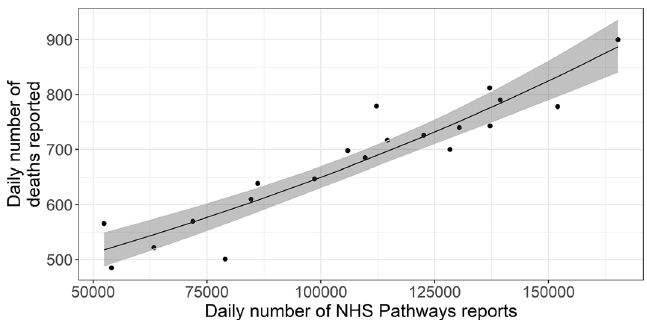
Figure 4. Daily total COVID-19 deaths reported in England between 3rd and 22nd April 2020, against the number of potential COVID-19 cases reported through NHS Pathways with a lag of 16 days (between 18th March and 6th April 2020). The black line and grey ribbon correspond to predictions from the regression model and associated 95% confidence intervals. The coefficient of determination indicates that 85.8% of the deviance in reported deaths is linearly explained by NHS Pathways